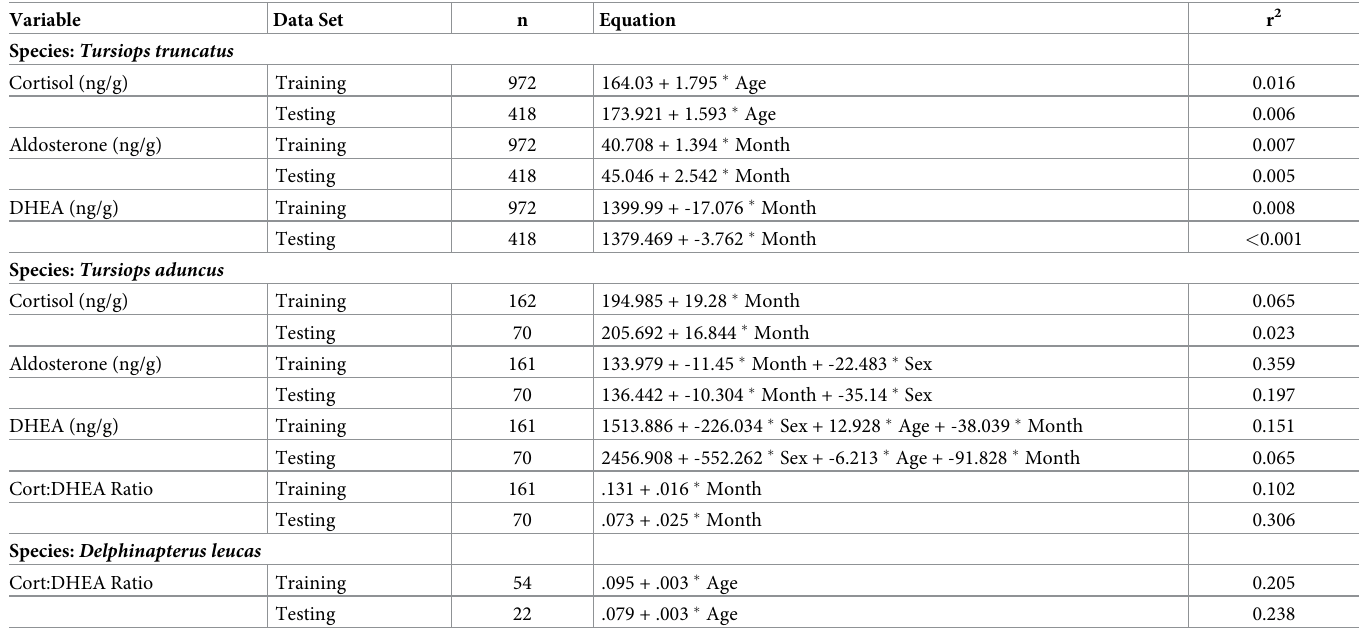
Table 1. Fit of predictions on training and testing dataset from linear regression models.